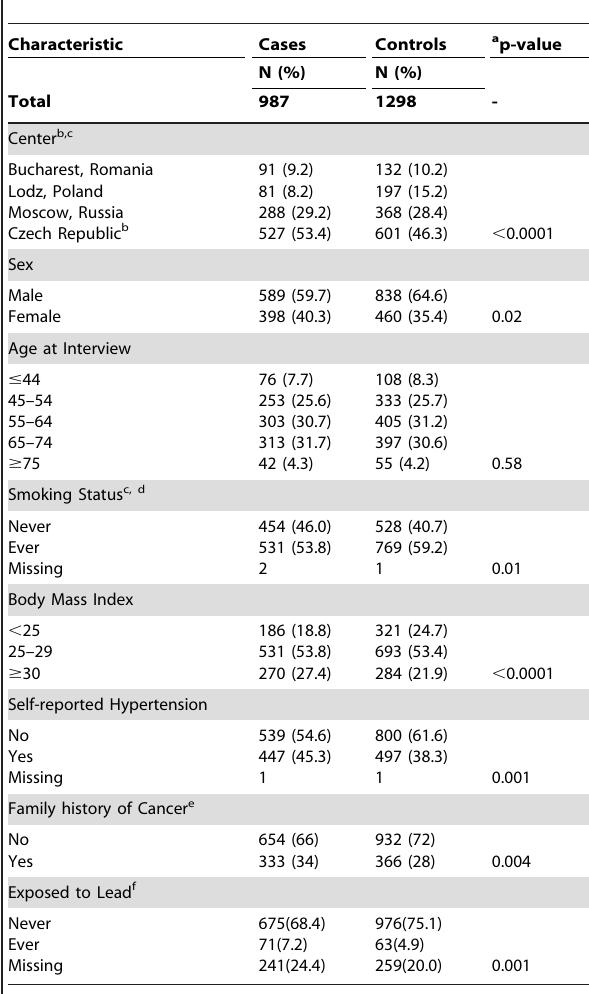
Table 2. Demographic characteristics of Subjects Genotyped in the Central Eastern European Renal Cancer